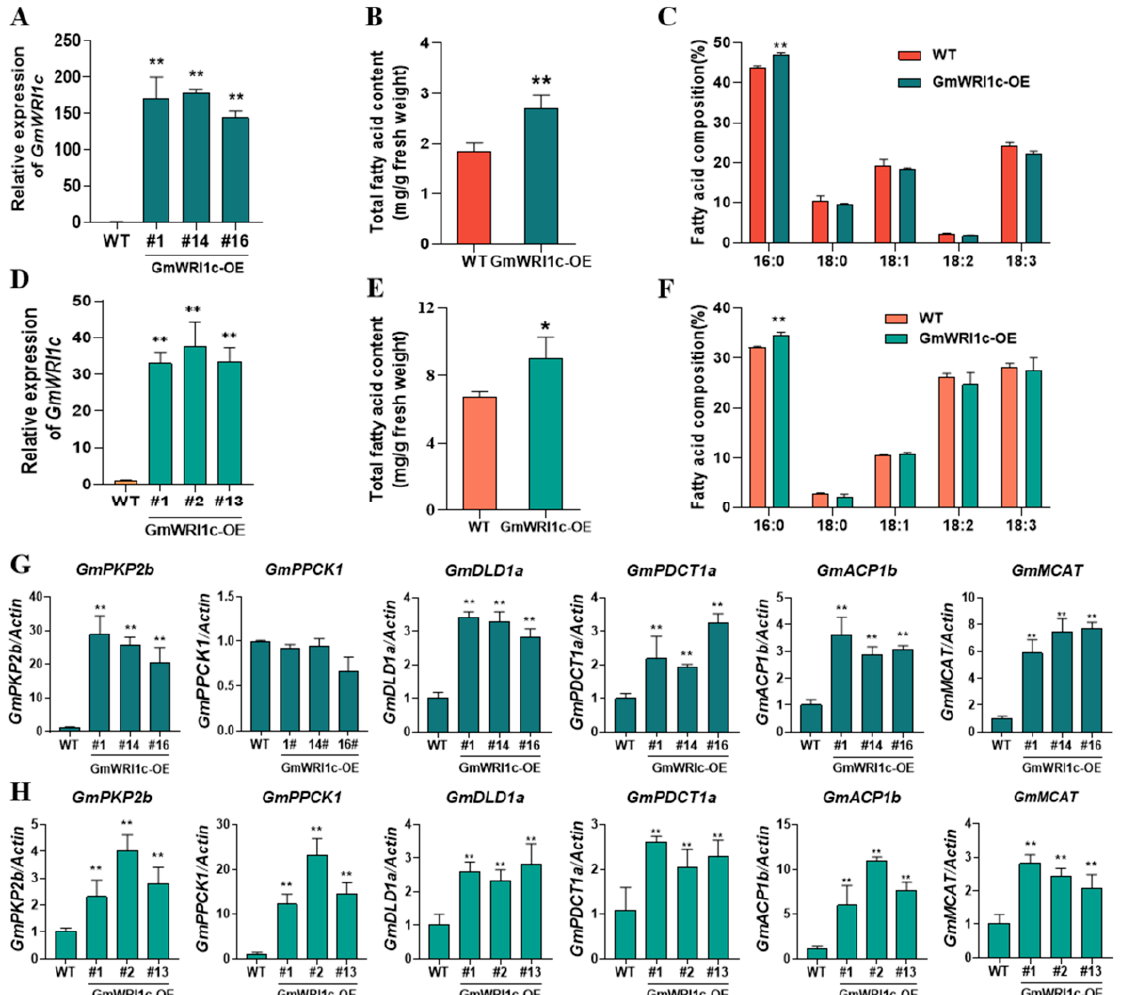
Figure 3. Analyses of GmWRI1c function in soybean. ( A ) Identification of transgenic hairy roots. ( B , C ) Total fatty acid content and fatty acid composition in GmWRI1c -OE transgenic hairy roots compared with control (values are means ± SD from three biological replicates). ( D ) Identification of transgenic root nodules. ( E , F ) Total fatty acid content and fatty acid composition in GmWRI1c -OE transgenic root nodules compared with control (values are means ± SD from three biological replicates). ( G ) Transcript levels of genes involved in glycolysis and de novo fatty acid synthesis in hairy roots of transgenic plants. ( H ) Transcript levels of genes involved in glycolysis and de novo fatty acid synthesis in root nodules of transgenic plants. * p < 0.05 and ** p < 0.01 (Student’s t